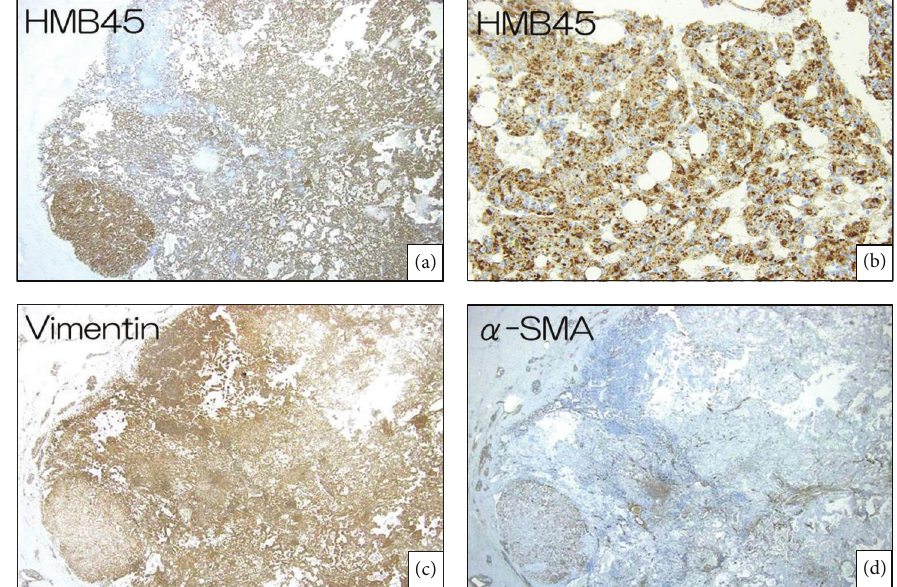
Figure 5: Immunopathological characteristics: tumor cells were positive for HMB-45 staining ( × 120) (a), ( × 1200) (b), for vimentin staining ( × 120) (c), and for 𝛼 -SMA staining ( × 120)